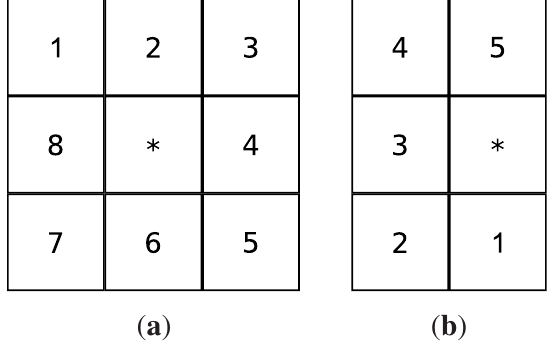
Figure 5. Two kinds of neighborhoods used to detect jumps in a DTM: (a) 8 neighborhoods; (b) 5 neighborhoods. The asterisk represents the DTM location being